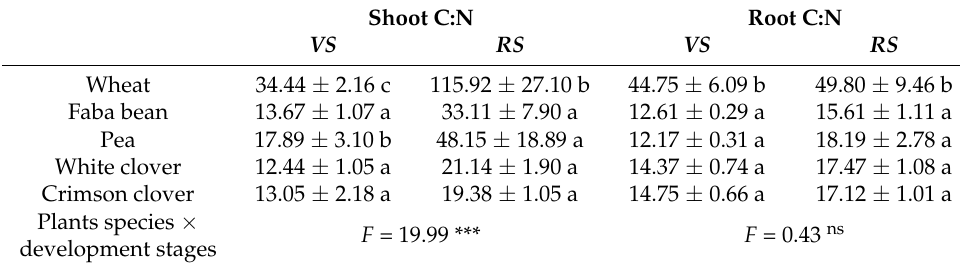
VS: vegetative stage; RS: reproductive stage. Statistical data are expressed as means ± SD, n = 5. Means in a column followed by different letters show significant differences. ( p < 0.05), different letters mean significant difference according to the Tukey test. Two-way ANOVA analysis ( F values) showing the effect of the interaction between the plant species and the two development stages on soil chemical characteristics. *** p ≤ 0.001. ns: non significant.